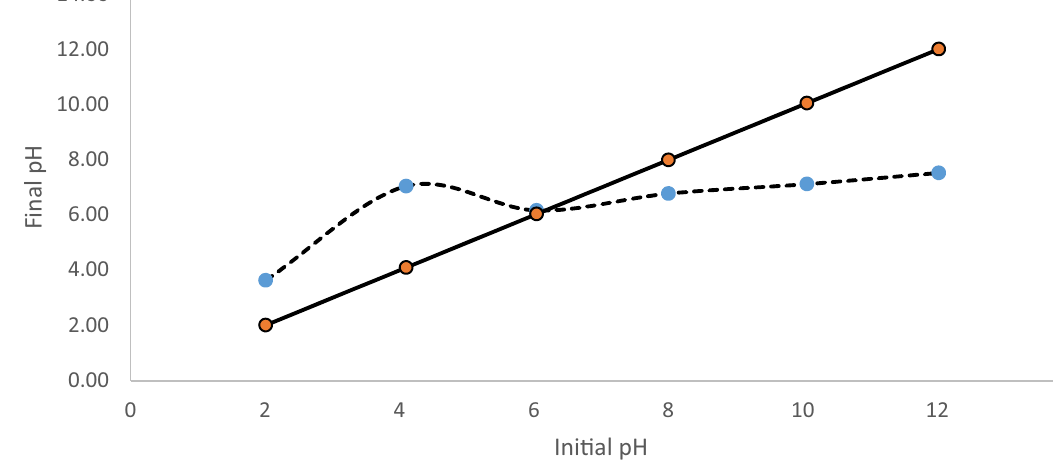
Fig. 2 The point of zero charge for the acid washed copper smelter